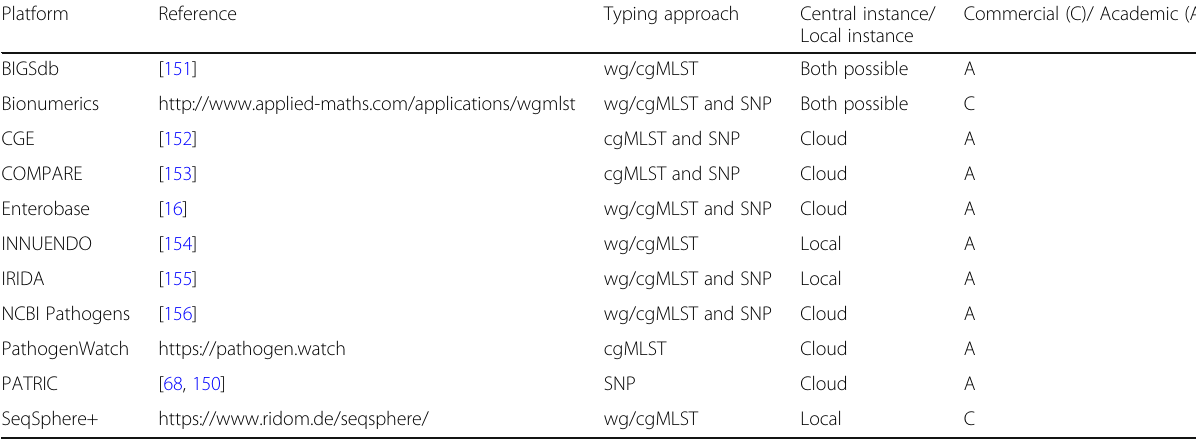
Table 4 Key characteristics of selected platforms